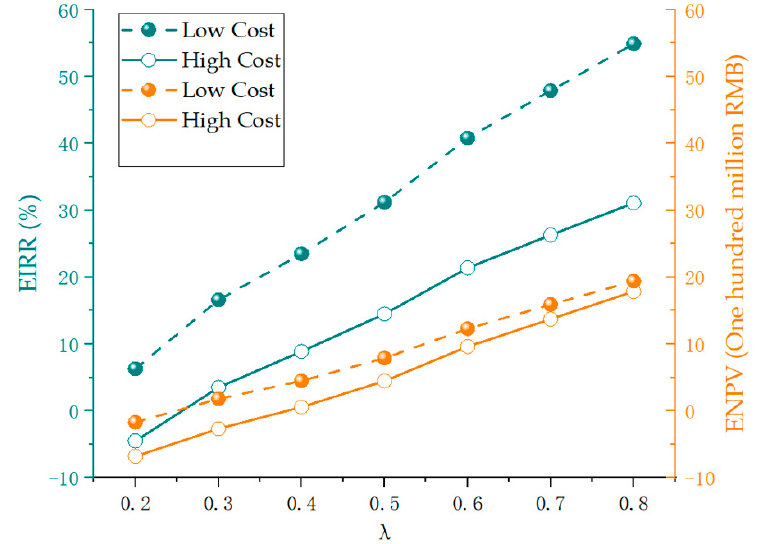
Figure 14. The highest and lowest cost EIRR and EPVN for different λ values.